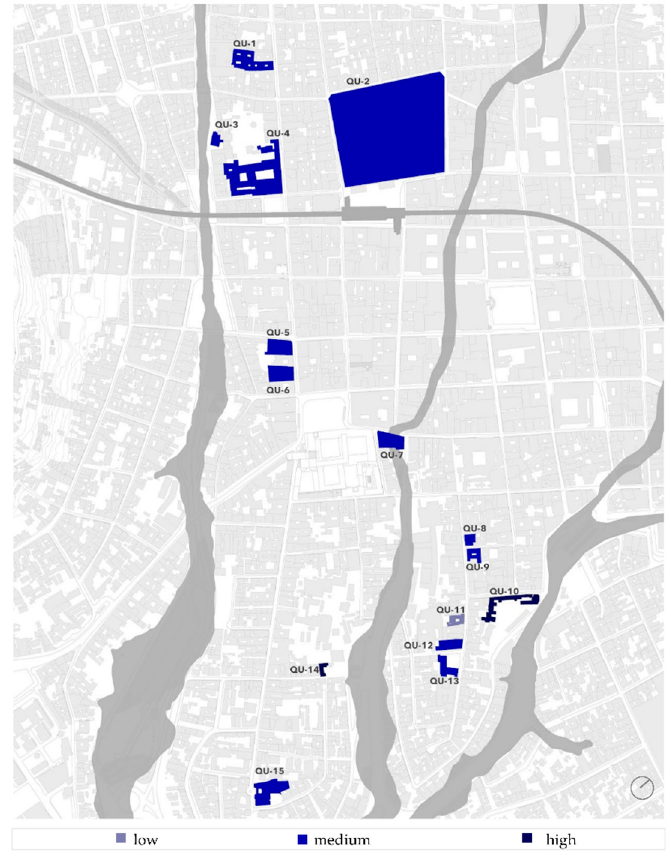
Figure 10. Vulnerability map of the Quito case studies. Scale: 1:8500.